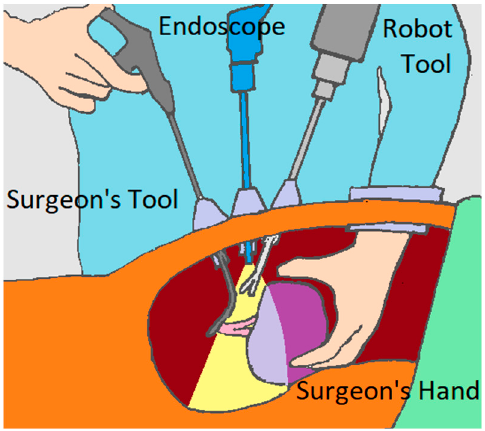
Figure 1. Hand-assisted laparoscopic surgery (HALS) scenario using a robotic assistant.